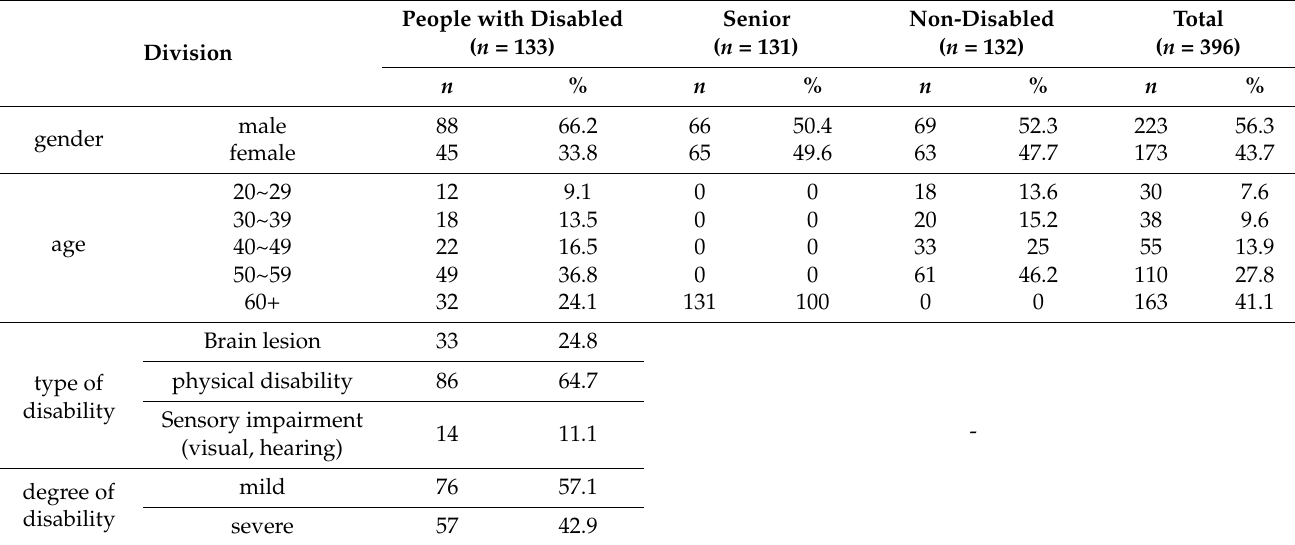
Table 3. Characteristics of participants in the first design concept idea acceptance evaluation.